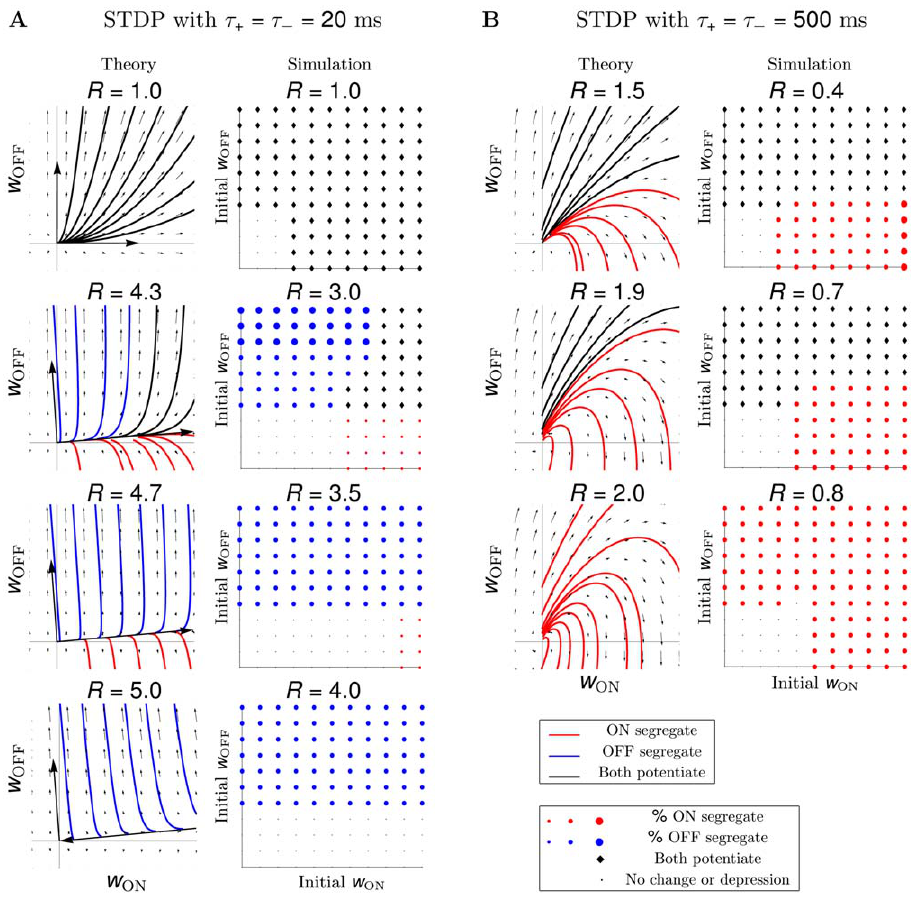
Figure 3. STDP without normalization does not result in segregation. (A) STDP with spike integration time windows of 20 ms results in ON/ OFF segregation only for two data sets out of six (data set 1 shown here; data set 2 not shown), assuming a depression-to-potentiation ratio, R ~ A { = A z , much larger than experimentally-observed. Theory and simulation show similar trends, although actual values of R differ. (Theory) Vector fields and example trajectories of the ON-OFF weight dynamics illustrate results from the linear model. The direction of two eigenvectors of the plasticity matrix Q (pointing out of the origin for a positive eigenvalue, and into the origin for a negative eigenvalue) determine how R affects segregation: as R increases, regions of initial conditions where both weights potentiate (trajectories in black) become areas where segregation occurs (trajectories in red for ON and blue for OFF). (Simulation) In the simulated integrate-and-fire model (here, data set 1 with 3 ON and 3 OFF inputs), a separate simulation was run for each initial condition uniformly sampled between 0 and the maximum weight value, w max , for the ON and the OFF weights. Here w max ~ 5 : 0 and the discrete steps for the initial weights were 0 : 5 . The colored symbol indicates the segregation outcome according to the legend, matching the color of the trajectories in the linear model. The size of the colored circles denotes the percentage of synaptic weights of a particular RGC type which potentiated maximally out of all RGCs of the same type initially wired to the LGN neuron (the three dots denote 33 , 66 and 100% , respectively), while all weights of the other RGC type depressed to 0. Initial weights too small to generate postsynaptic activity result in no synaptic change (dots in the bottom left region of each plot). (B) Extending the spike integration window to match the timescale of the input correlations to 500 ms, results in pure dominance of the ON cells, both under the theoretical and the simulated model and for any value of the ratio R (data set 1 shown here, but all others show the same behavior).